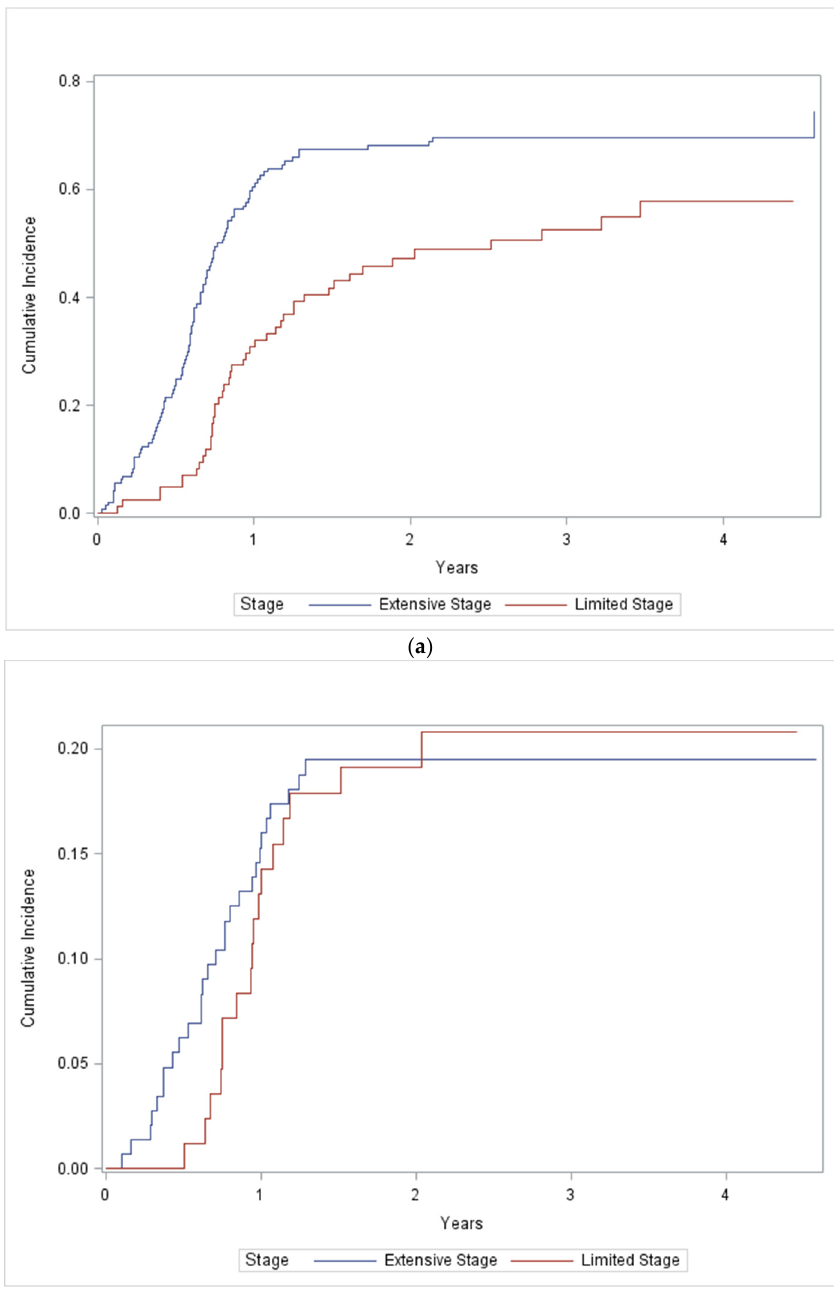
Figure 2. Cumulative incidence of thoracic ( a ) and CNS ( b ) recurrence. CNS recurrence occurred less commonly than thoracic recurrence. Overall, 22% of patients experienced CNS recurrence, with a similar incidence in both LS and ES SCLC (19% vs. 23%). Similar rates of CNS recurrence in the entire cohort were documented in patients who did or did not receive PCI (20% vs. 23%). For patients with LS SCLC, CNS recurrence occurred in nine (18%) patients who did and seven (21%) patients who did not receive PCI. There were similar numbers of CNS only and CNS plus systemic recurrences (11% vs. 8%). For patients with ES SCLC, CNS recurrence occurred in 7 (23%) patients who received PCI and 27 (24%) patients who did not receive PCI. Fewer patients with ES SCLC had CNS as the only site recurrence (8% vs. 16%). The cumulative incidence of CNS relapse at 12 and 24 months was 13% and 19% for LS SCLC and 16% and 20% for ES